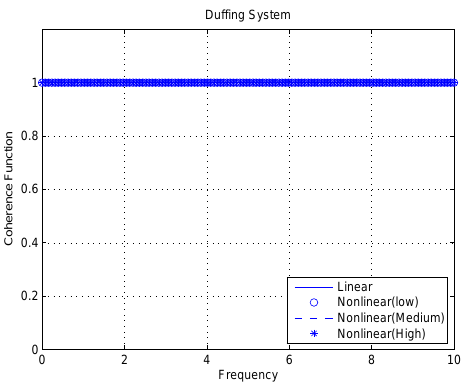
Figure 2: Coherence function of Duffing system in lin- ear and nonlinear modes with a periodic ex- citation signal